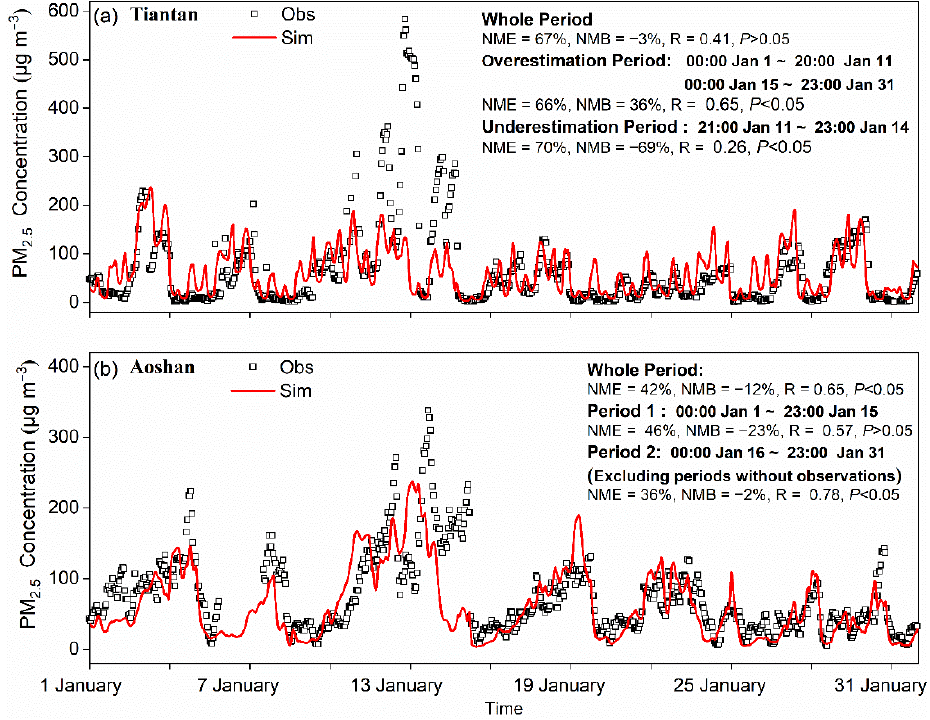
Figure 4. The comparison of measured and simulated concentrations of PM 2.5 at Tiantan in Beijing and Aoshan in Qingdao during January 2019. and Aoshan in Qingdao during January